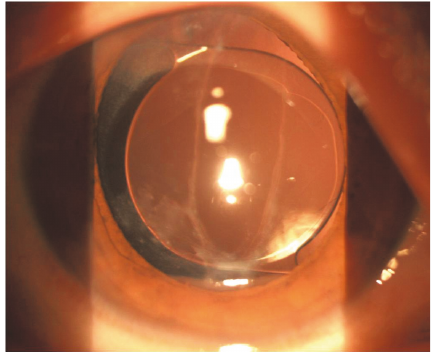
Figure 2: Postoperative slit-lamp photographs of Case 3 with a longitudinally ruptured posterior capsule. The anterior chamber maintainer was placed under lens cortex aspiration, and the intraoc- ular lens was inserted into the